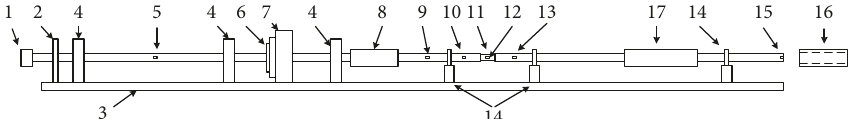
Figure 17: A biaxial TSHB for simultaneous torsion and compression designed by Lewis and Goldsmith [69].1: torque handle; 2: clamping block; 3: machine bed plate; 4: bearing block; 5: static torque gauge; 6: holding flange; 7: holding frame; 8: torsional bending suppressor; 9: bending strain gauge; 10: longitudinal strain gauge; 11: specimen; 12: specimen strain gauge; 13: torsion strain gauge; 14: alignment post; 15: crossed wire trigger; 16: air gun; and 17: longitudinal bending suppressor.